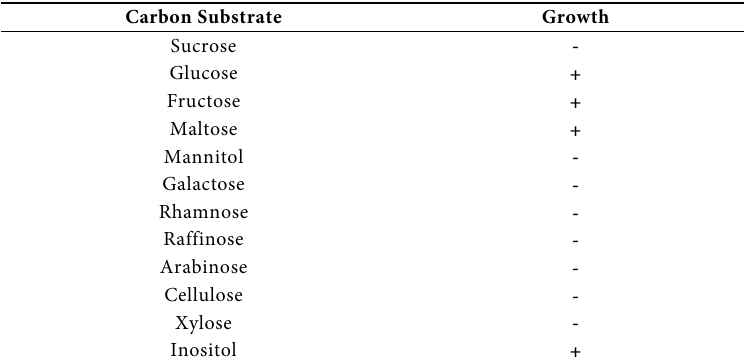
Table 3. Utilization of different carbon source (+ Growth, - No growth)